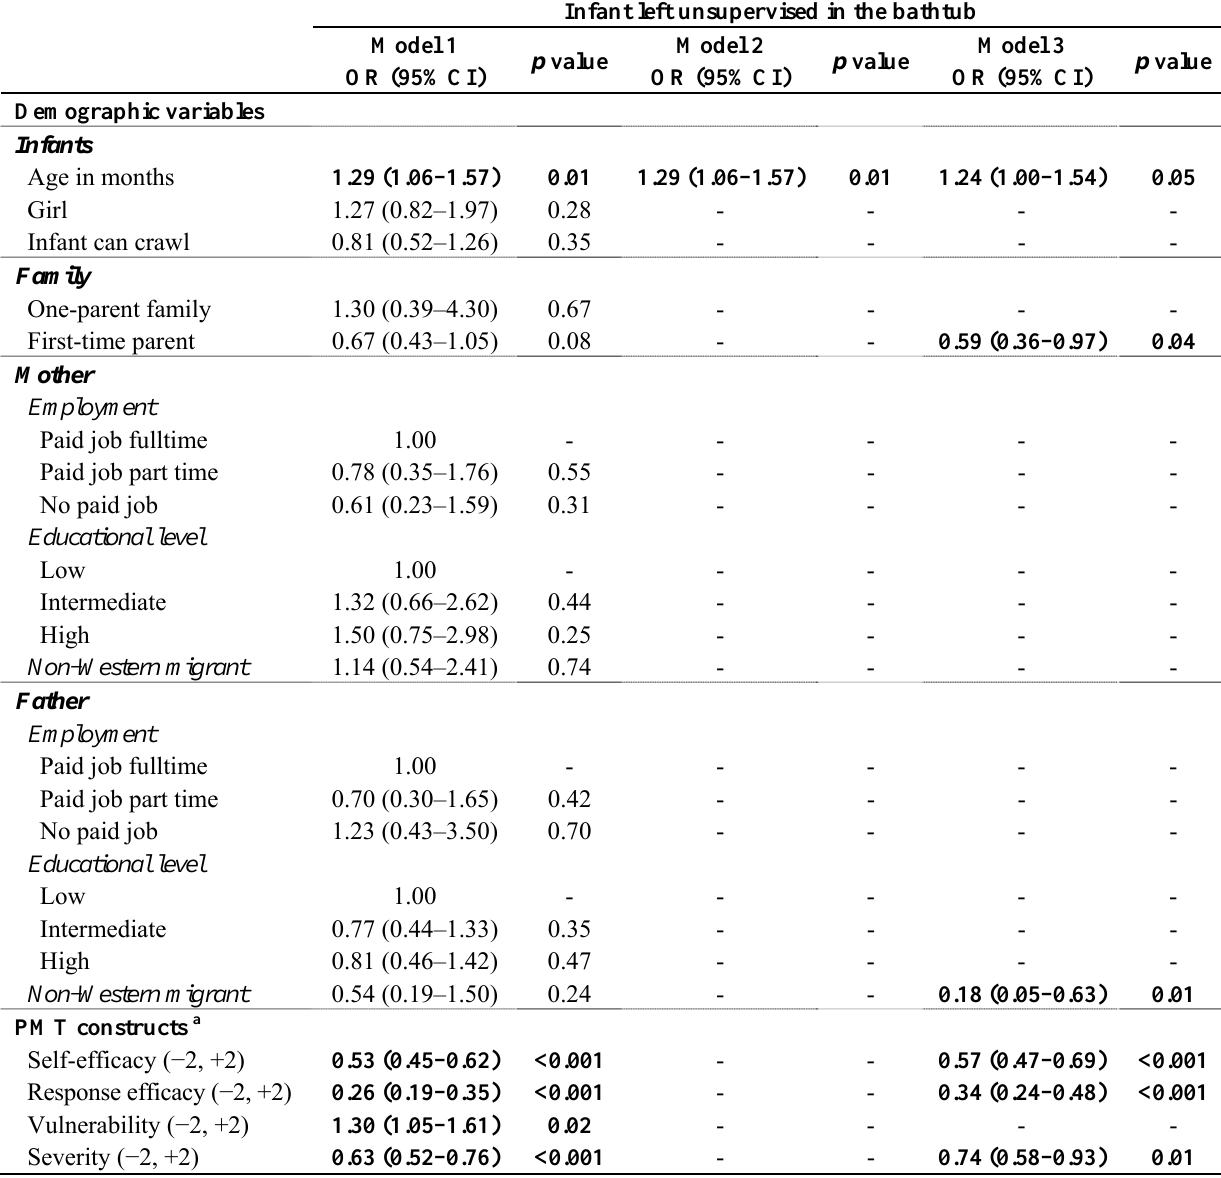
Table 2. Odds ratios (OR) and 95% confidence intervals from univariate (Model 1) and multiple logistic regression analyses with leaving the infant unsupervised in the bathtub as dependent variable and demographic variables (Model 2) and Protection Motivation Theory (PMT) variables (Model 3) as independent factors (n =